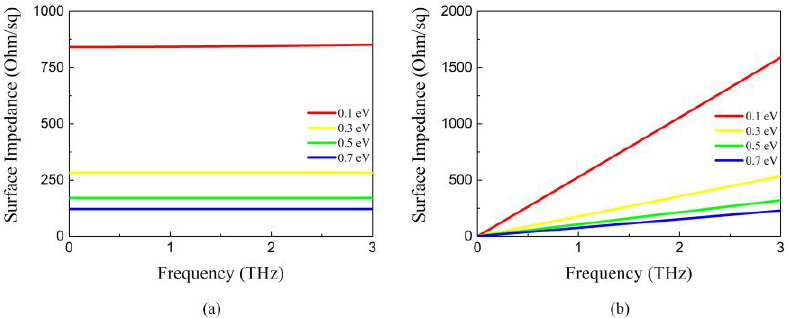
Figure 1. Surface impedance of graphene with different chemical potential ( a ) Real part ( b ) Imaginary part.